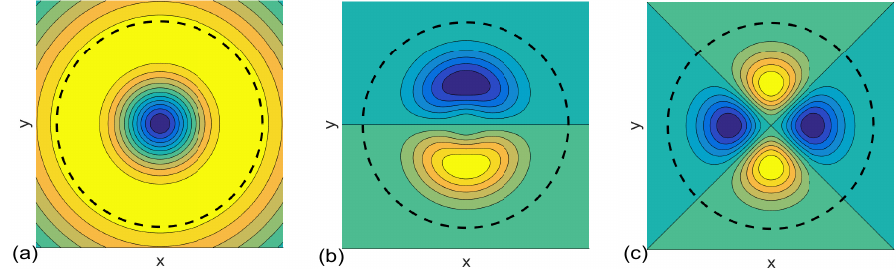
Figure 5. Representation of the three components of the streamfunction. Panel (a) indicates ε 0 (cid:57) 0 for a = 2 and ε 0 < 0; (b) (cid:57) 1 ; and (c) (cid:57) 2 for d = 1, w 2 =